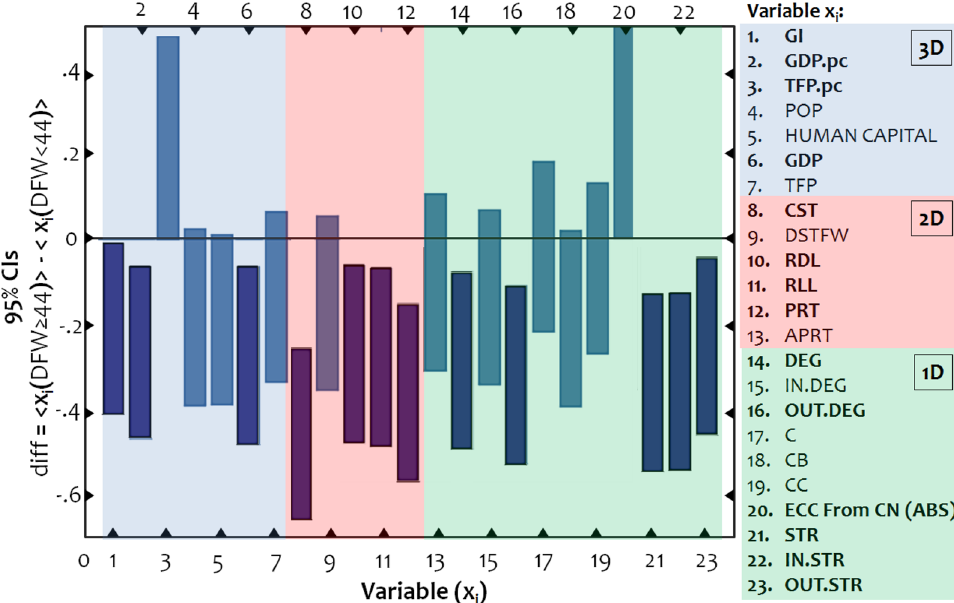
Figure 6. Error bars of 95% confidence intervals (CIs) for the average differences (cid:31) diff( x i ) (cid:30) , computed on standardized variables (ranging from 0 to 1) between the groups of cases x ( t < 44DFW) and x ( t ≥ 44DFW) defined by the cutting value t = 44DFW (the number of days since the first infection in Wuhan), for each of the available network and economic variables ( x 1 , x 2 , …, x 19 ). Labels shown in bold font have significant